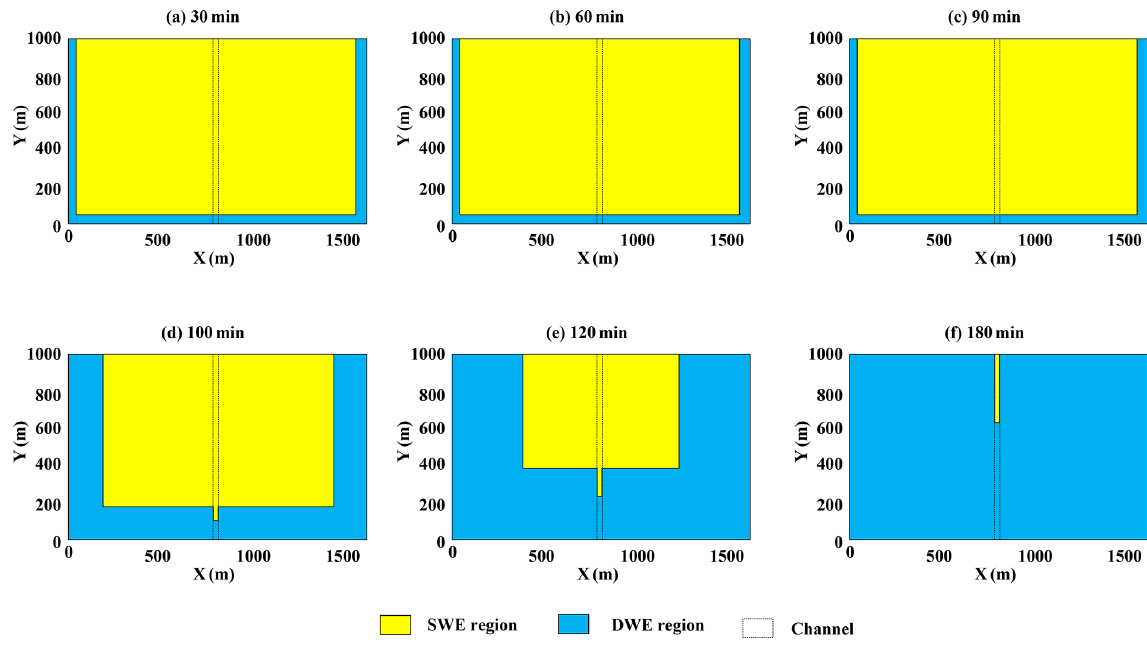
Figure 16. Evolution of coupling